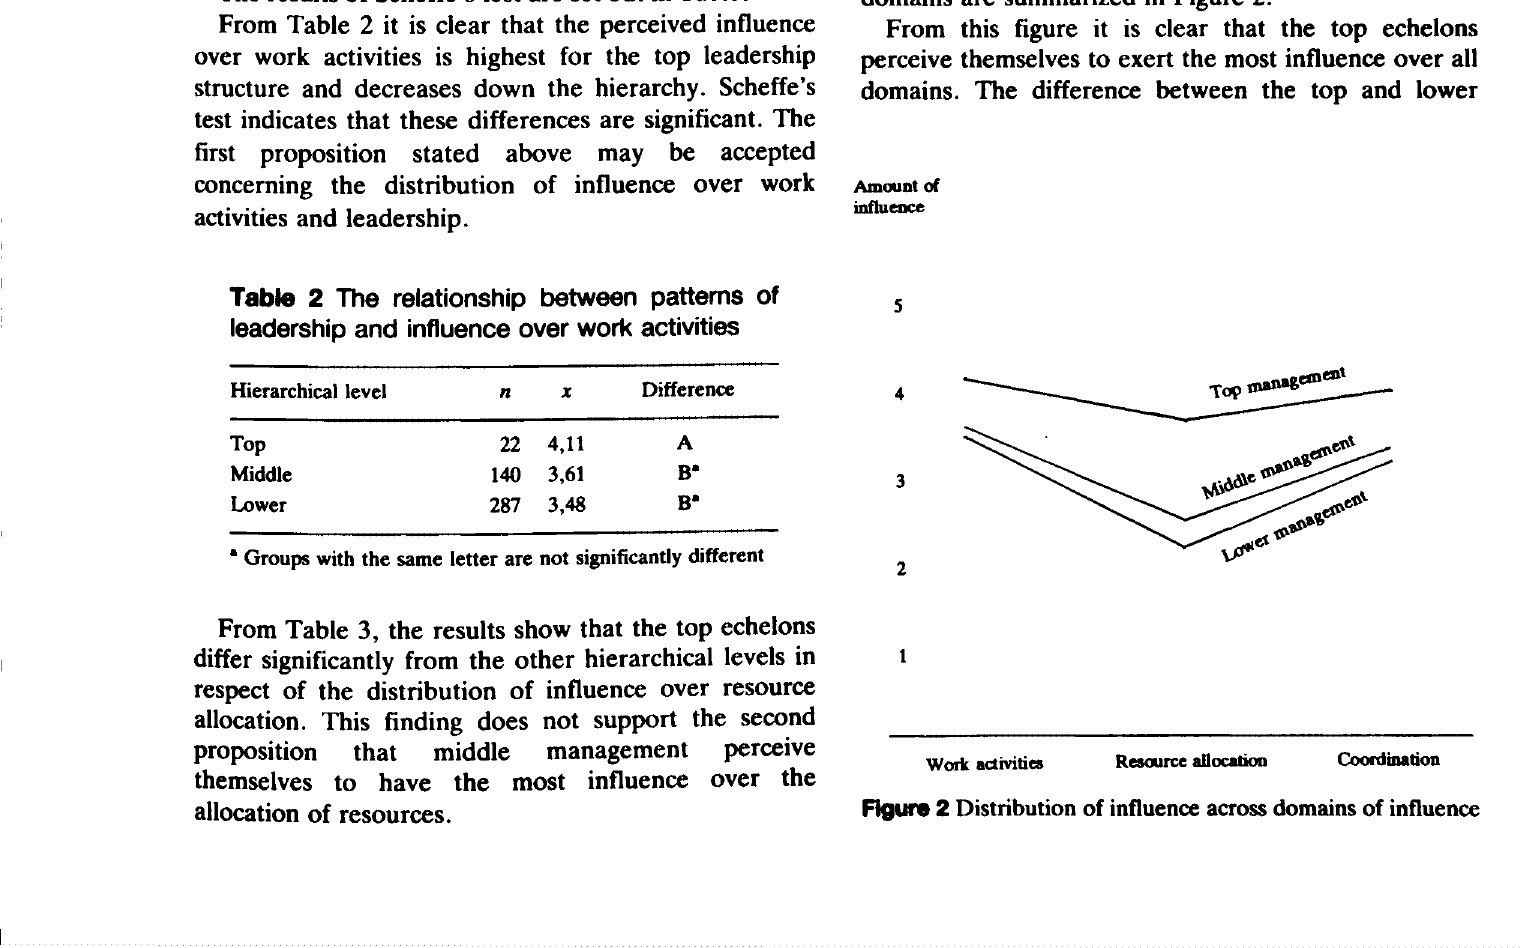
Figure 2 Distribution of influence across domains of